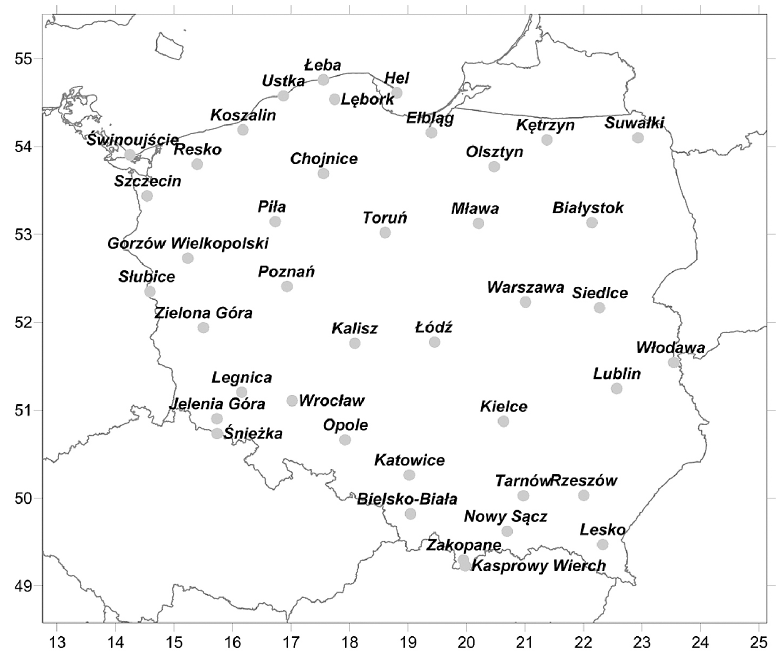
Fig. 1. Localization of analysed